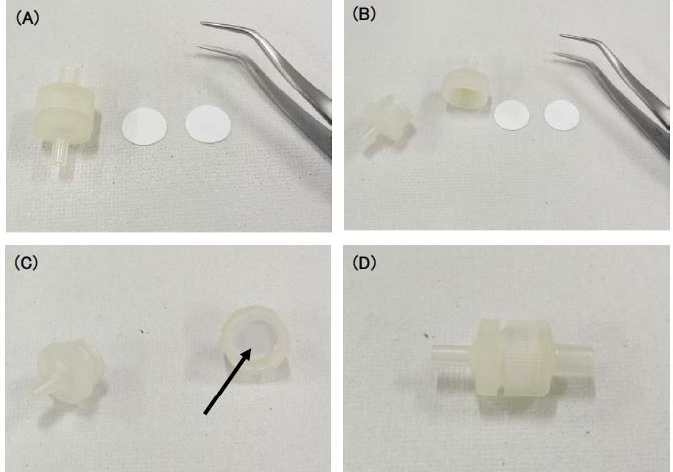
Figure 1. Setting SiO 2 -nanofiber (NF) filters in a syringe filter unit. ( A ) A syringe filter unit (left), two sheets of punched SiO 2 -NF filters (middle), and a tweezer (right). ( B ) Opened syringe filter unit. ( C ) Setting two sheets of the SiO 2 -NF filters (arrow) with the tweezer. ( D ) Closed syringe filter unit.